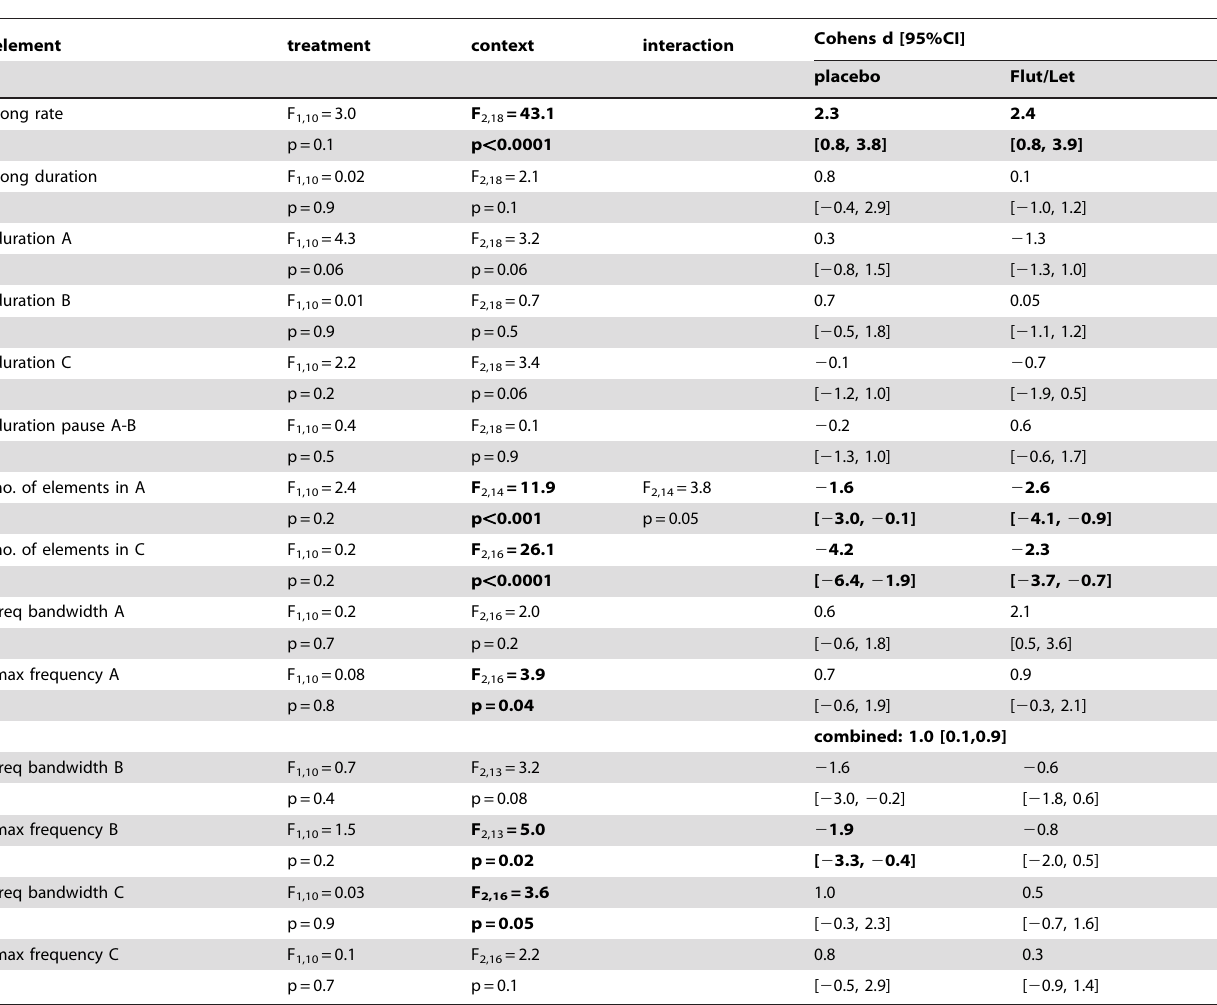
Table 2. Linear mixed model results for the effects of context and Flut/Let treatment on song output and structure in fall.